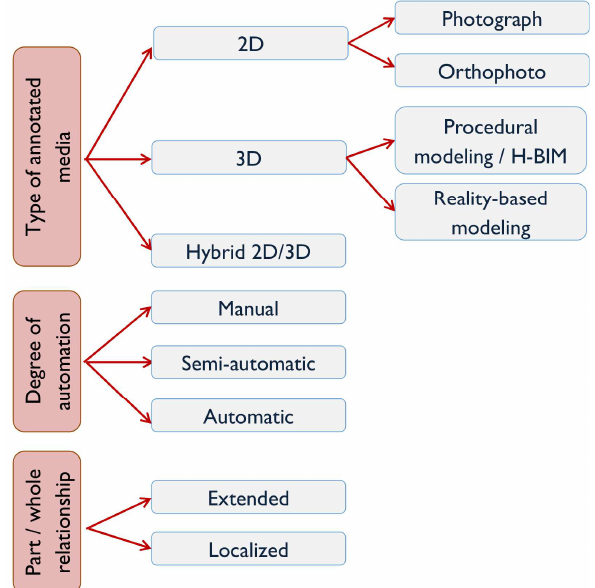
Figure 1. Classification of semantic annotation over digital heritage